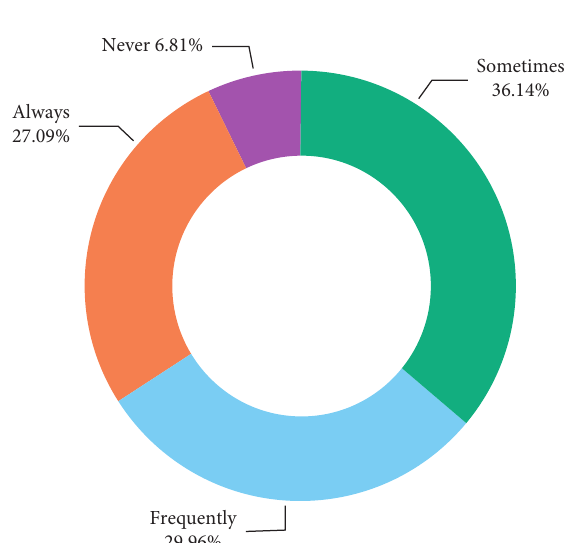
Figure 6: Involvement of professors.